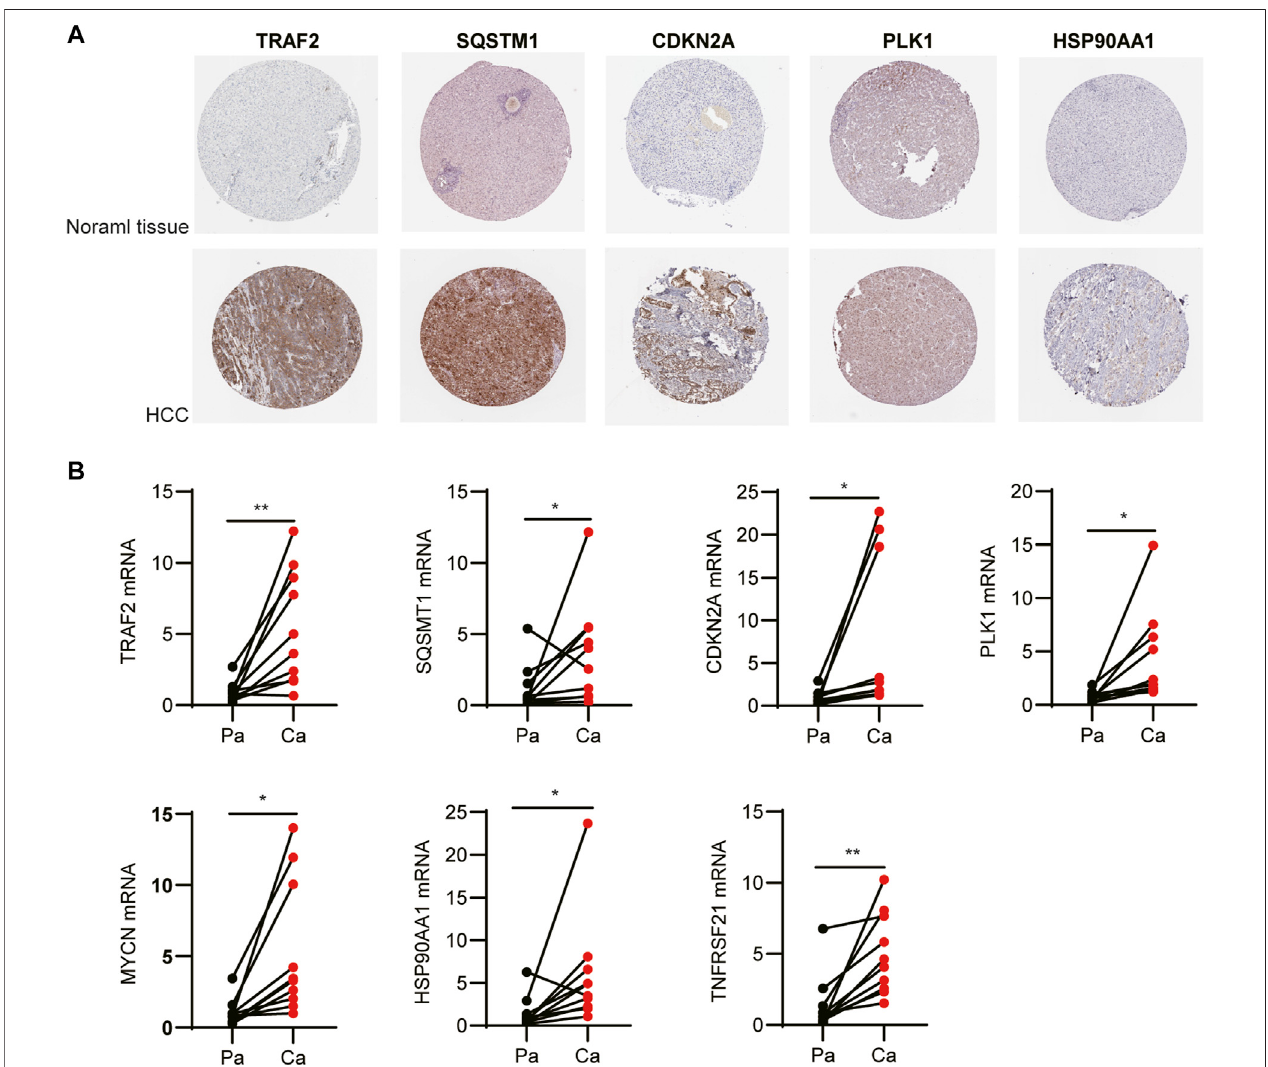
FIGURE10| Expressionoftheindependentprognosticgenes. (A) Immunohistochemistryof TRAF2 , SQSTM1 , CDKN2A , PLK1 ,and HSP90AA1 inthenormaland tumor groups from theHuman ProteinAtlas database. (B) The mRNAlevelsof TRAF2 , SQSTM1 , CDKN2A , PLK1 , MYCN , HSP90AA1 ,and TNFRSF21 were measured by